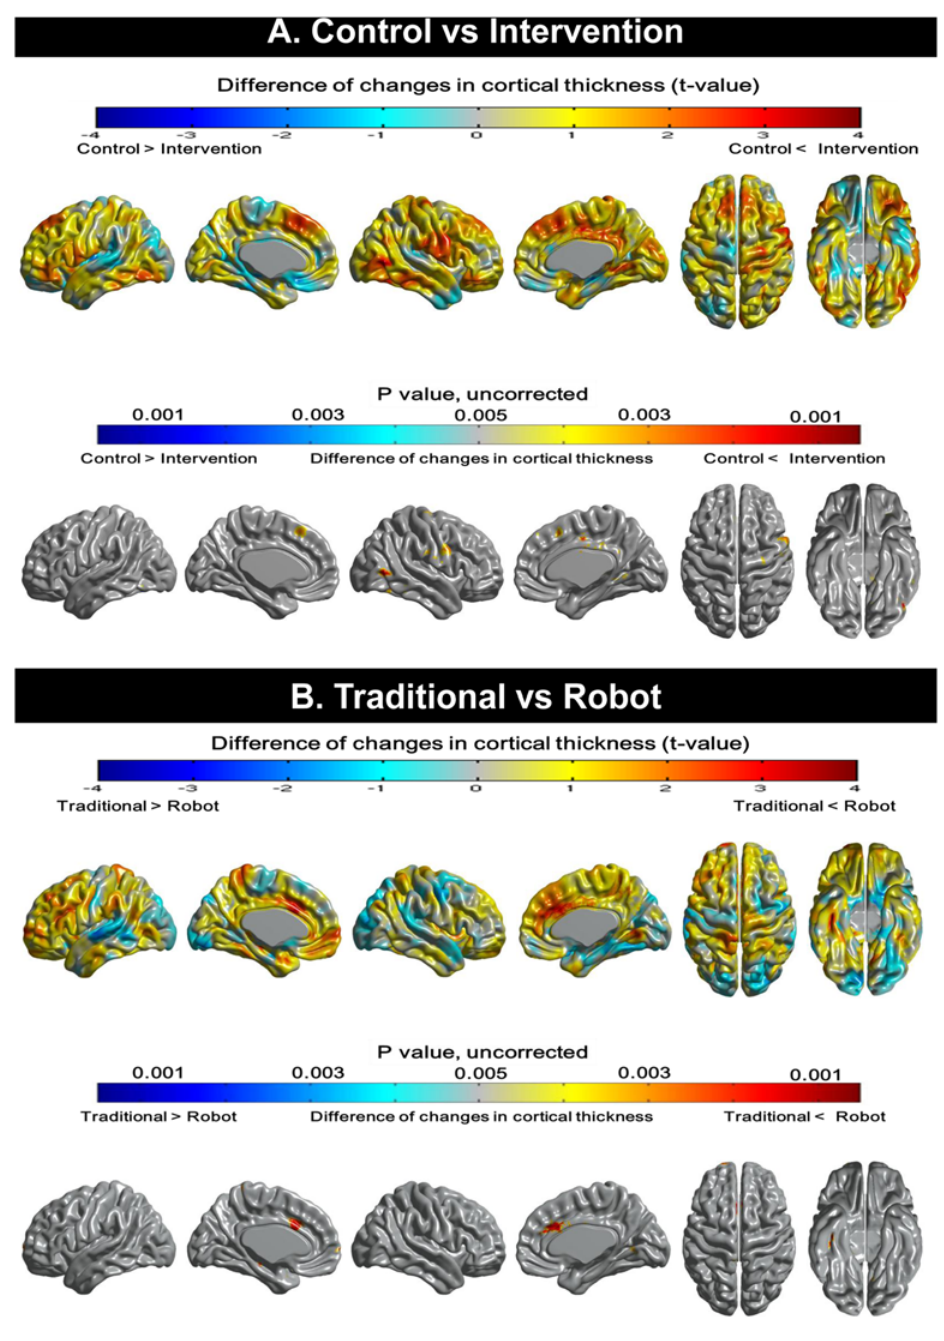
Fig 2. Topographical changes in cortical thickness. (A) Compared to the control group, the intervention group shows attenuated cortical thinning on heteromodal association cortices such as the bilateral medial prefrontal and right middle temporal gyrus. (B) When the traditional and robot groups were directly compared, significantly reduced cortical thinning on the bilateral anterior cingulate cortices and right inferior temporal cortex was evident in the robot group. No area demonstrated less cortical thinning in the traditional group than the robot